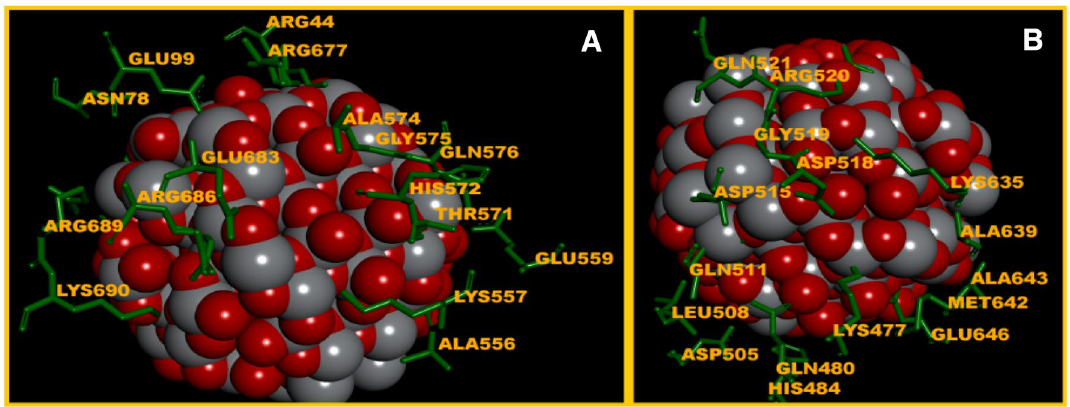
Figure 9. ( A ) The first binding site of TiO 2 with myosin II (Score—7910, Area—1101.40 Å 2 , ACE—204.62); ( B ) the second binding site of TiO 2 with myosin II (Score—7724, Area—947.20 Å 2 ,